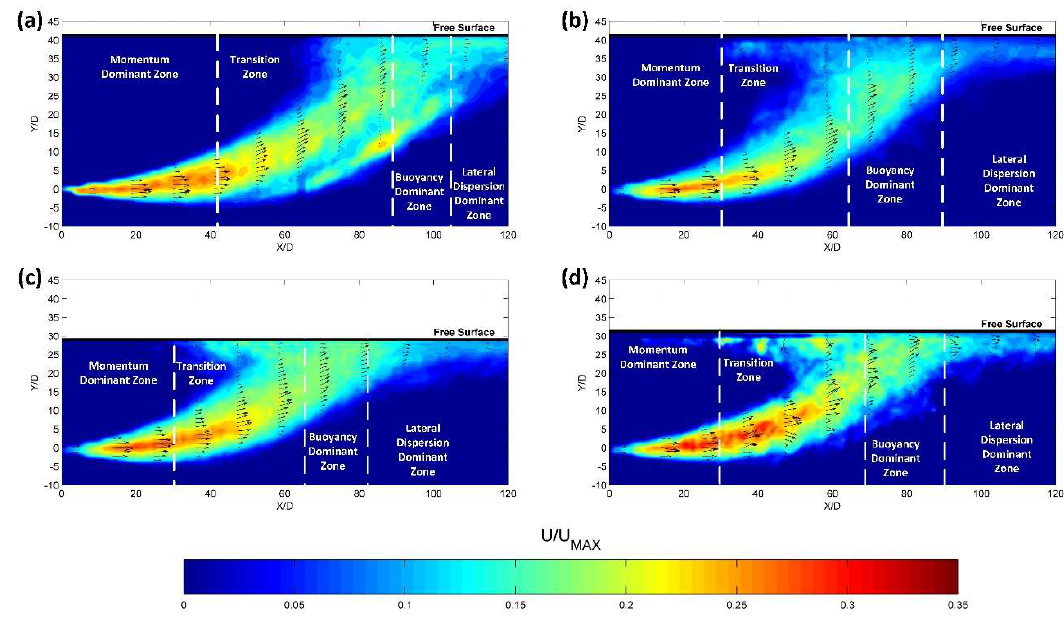
Figure 4. Dimensionless time-averaged velocities (U / U MAX ) in a longitudinal view of the positively buoyant jet advance at the nozzle XY plane for the physical tests V1 ( a ), V2 ( b ), V3 ( c ), and V4 ( d ).